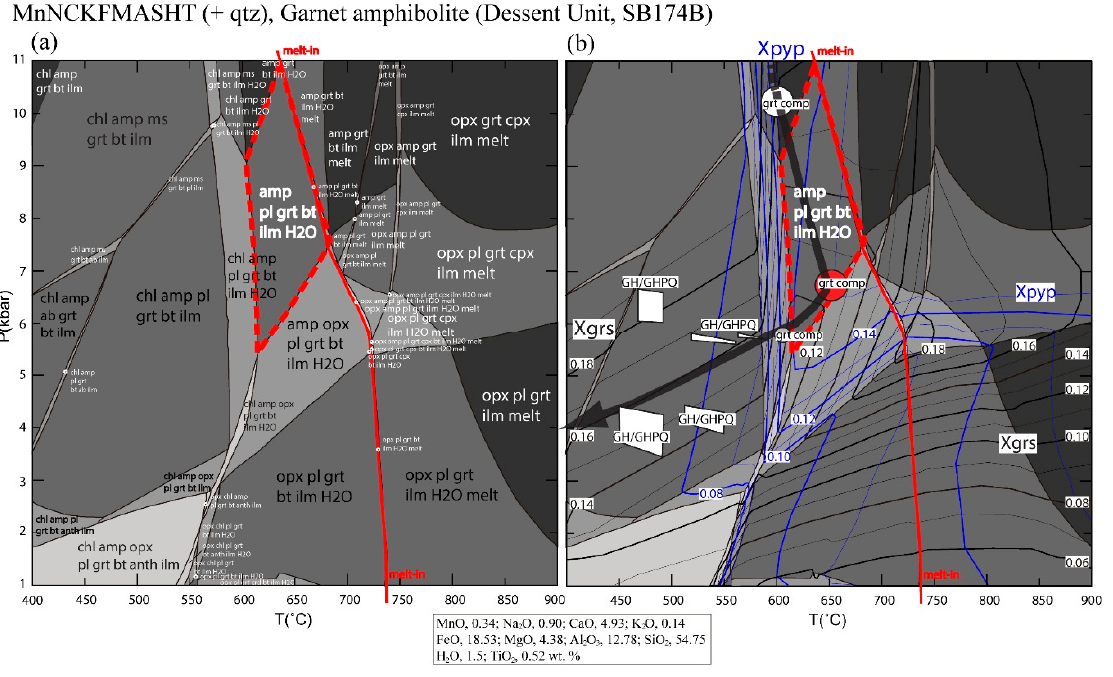
Figure 9. ( a ) P–T pseudosection for the amphibolite (SB174B) in the MnNCKFMASHT system. ( b )